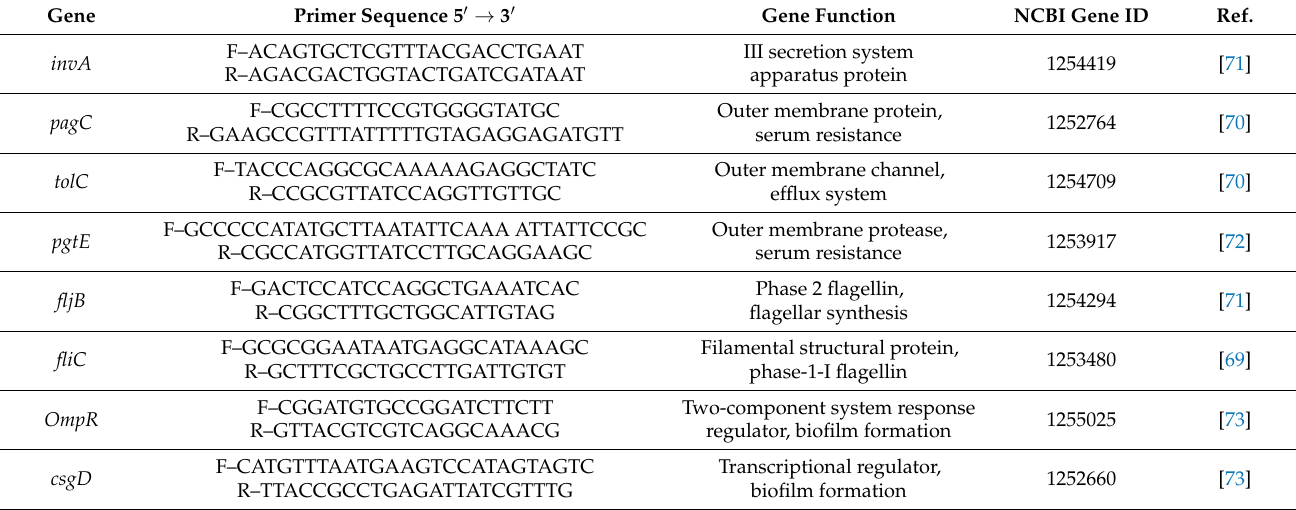
Table 7. Primers and functions of genes detected in this